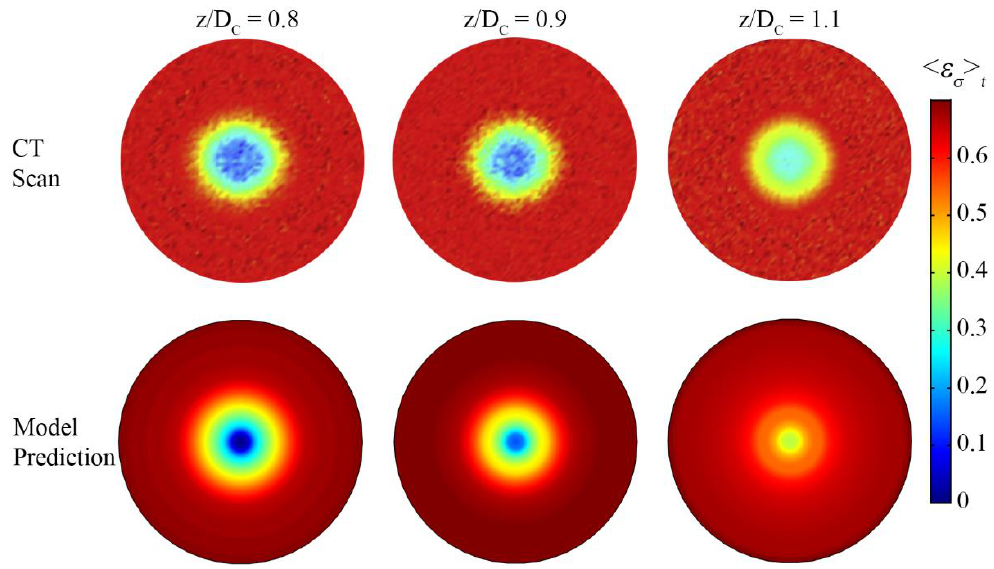
Figure7. ComparisonbetweenCTscanresultsandmodelpredictionofthetimeaveragedcross-sectional Figure 7. Comparison between CT scan results and model prediction of the time averaged cross- solids holdup distribution for a spouted bed packed with 2 mm glass beads, H σ ,0 = 160 mm and sectional solids holdup distribution for a spouted bed packed with 2 mm glass beads, (cid:68) (cid:69) V β / V ms = 0